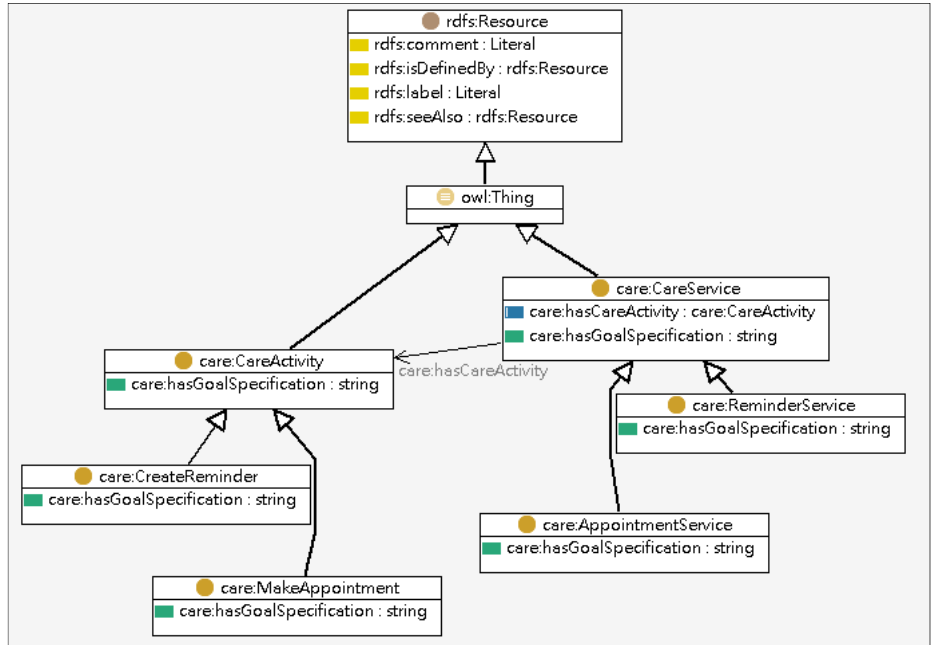
Figure 4. Partial model of the care ontology.